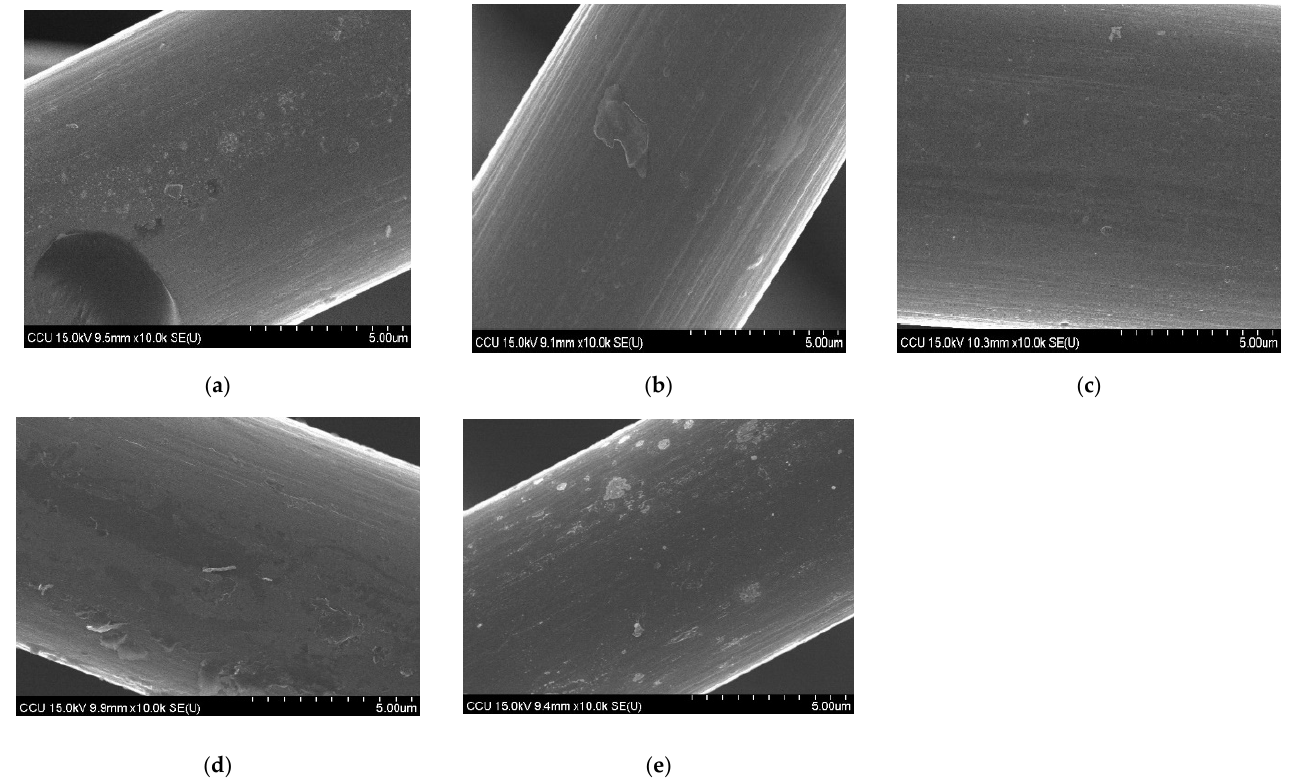
Figure 4. SEM images of GF electrode: ( a ) untreated; ( b ) H 2 SO 4 treatment; ( c ) APPJ 450 °C treatment; ( d ) APPJ 550 °C treatment; ( e ) APPJ 650 °C treatment.